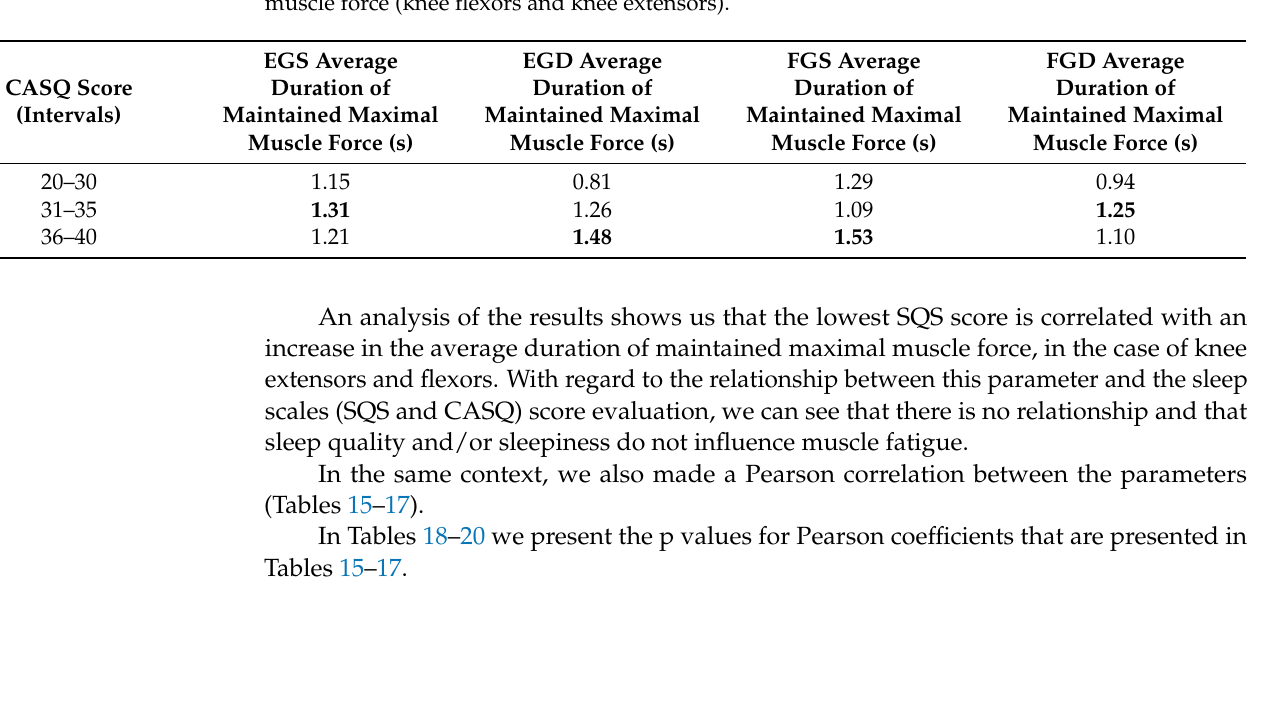
Table 14. Correspondence between each CASQ score group and average duration of maintain the muscle force (knee flexors and knee